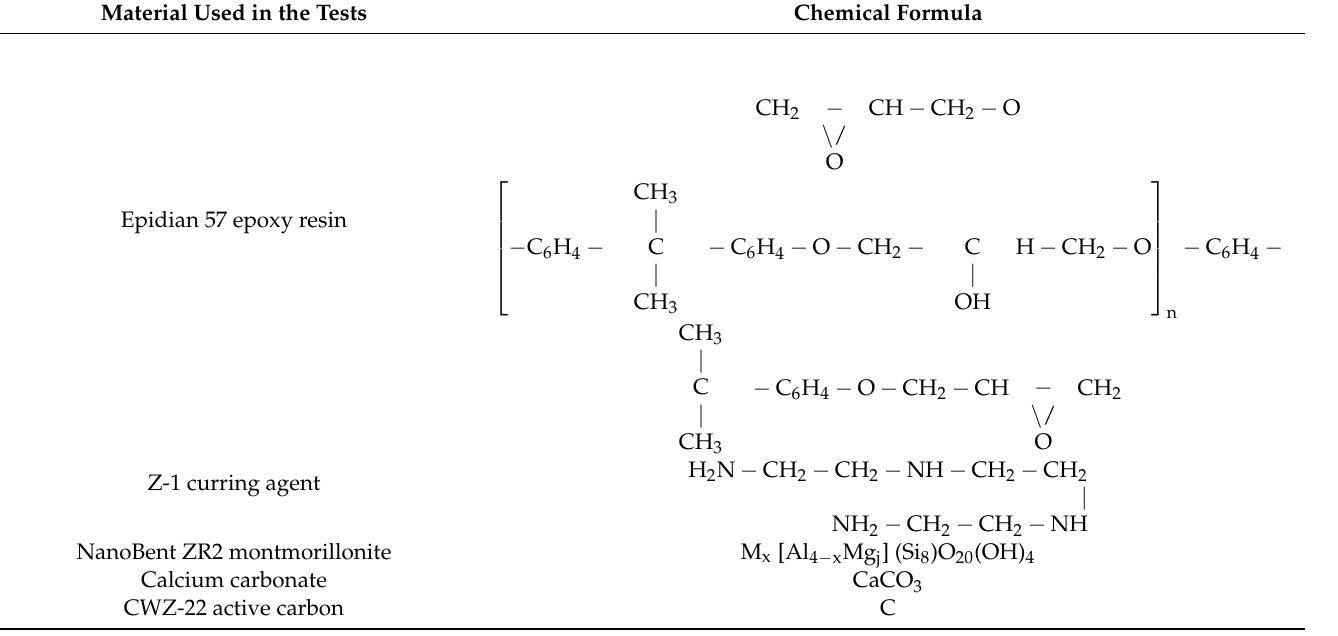
Table 1. The chemical formulas for the materials used in the tests.